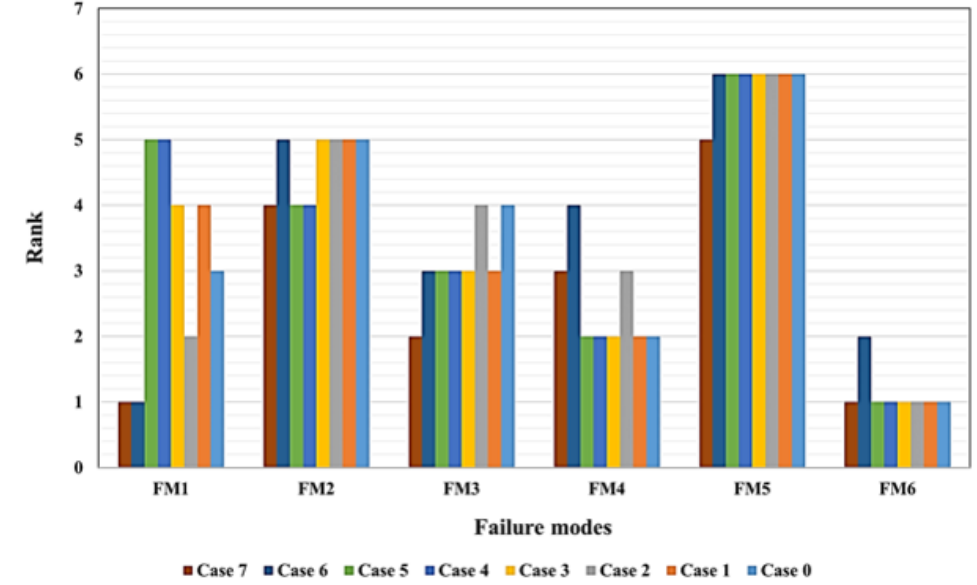
Figure 4. Sensitivity analysis for studied case studies with constant α . DependsonFigure5, byvaryingvariable α (UFC)from0.0to1.0, FM2, FM5, andFM6reserve their position in the ranking, but FM1, FM3, and FM4 change their situations. In considered UFC ( α = 0.489 ) , the failure modes ranking is FM6 > FM4 > FM1 > FM3 > FM2 > FM5, while a change of α can vary this ranking as shown in Figure 5.